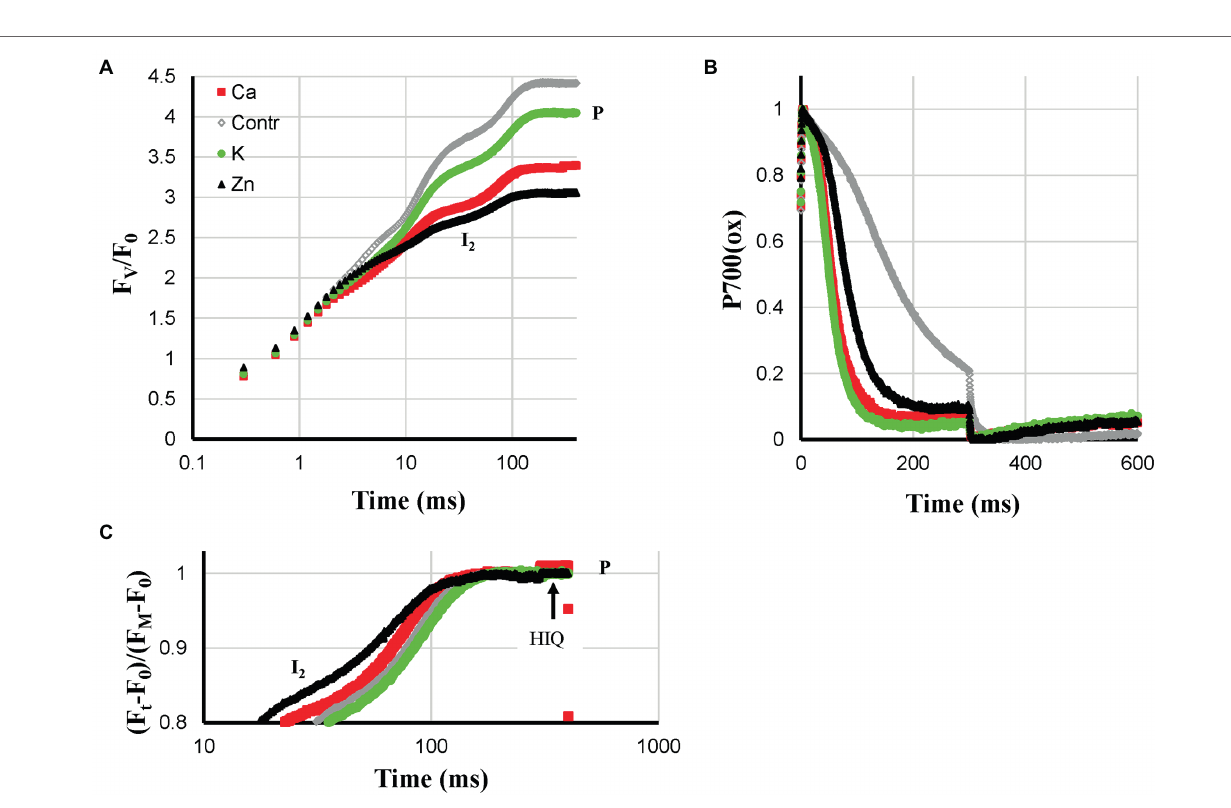
FIGURE 4 | Effect of Ca-, K- and Zn-deficiencies applied to hydroponically grown sunflower plants on the polyphasic rise (A) and P700 + (B) kinetics, respectively. In panel (C) the double-normalized I 2 -P amplitudes are shown to allow a comparison of the rise kinetics. The transients are averages of four independent